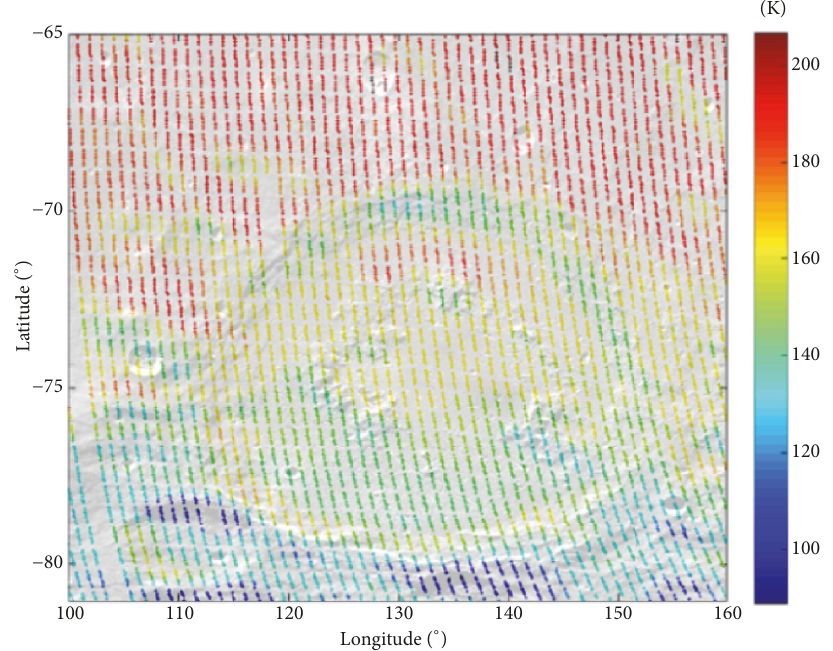
Figure 2: Scatter map of the 37-GHz CELMS data at noon overlays on WAC